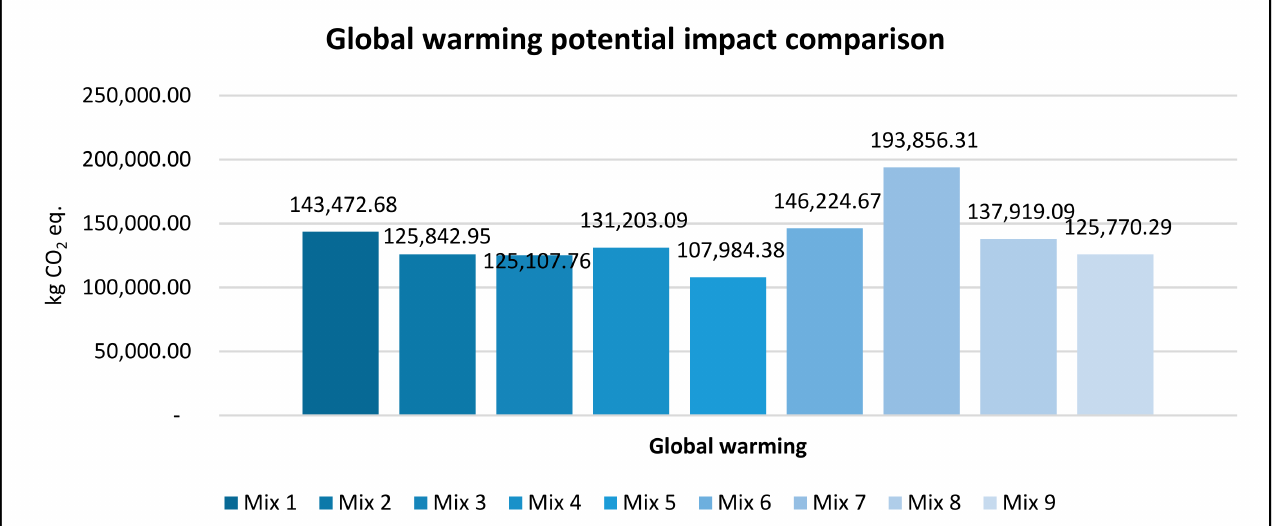
Figure 5. Mineral sealing layer—Contribution analysis for GWP impact category.